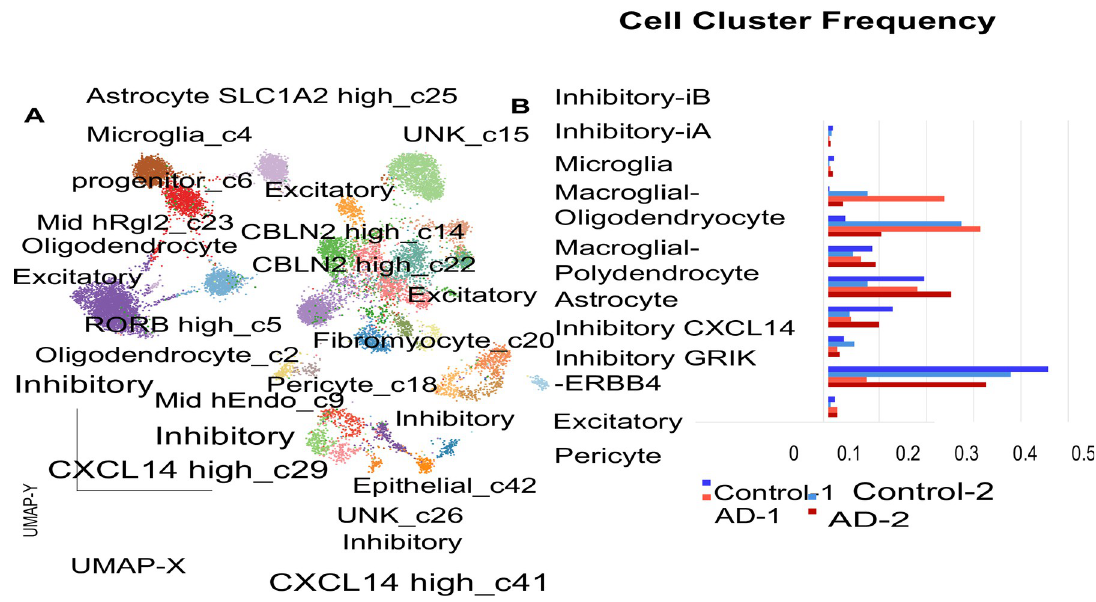
Fig 3. HCL of the AD and control samples. A) HCL of the Alzheimer’s and control samples (yellow—up regulation, blue/black—down regulation of expression). Top colormap: Range from -1.4 to 1.4 log fold change. Left colormap marks the different neuronal cell groups. Right: The gene symbols and p-values, bottom grey colorbar: Grouping of the samples (white, grey scale and black). P values are indicated on the right. Left: Molecular pathway names and p values top panel: Cell type marker genes right: Altered genes + p values. X axis: AD vs control fold change (from